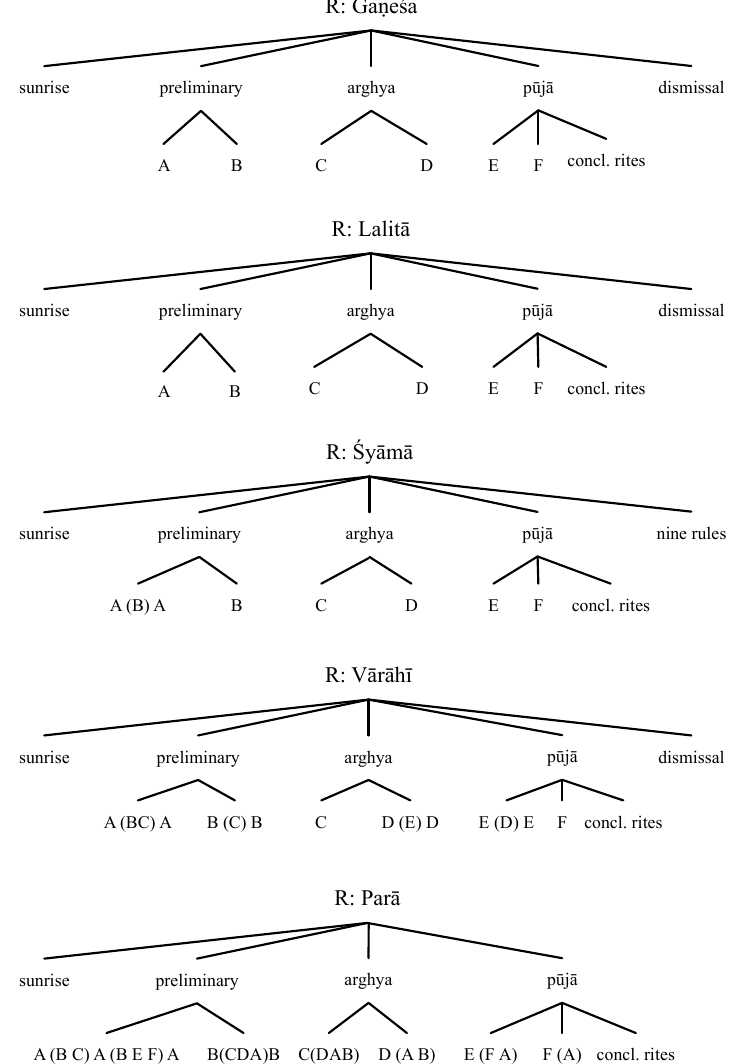
Figure 1. Syntax of Rituals Studied by Wilke.